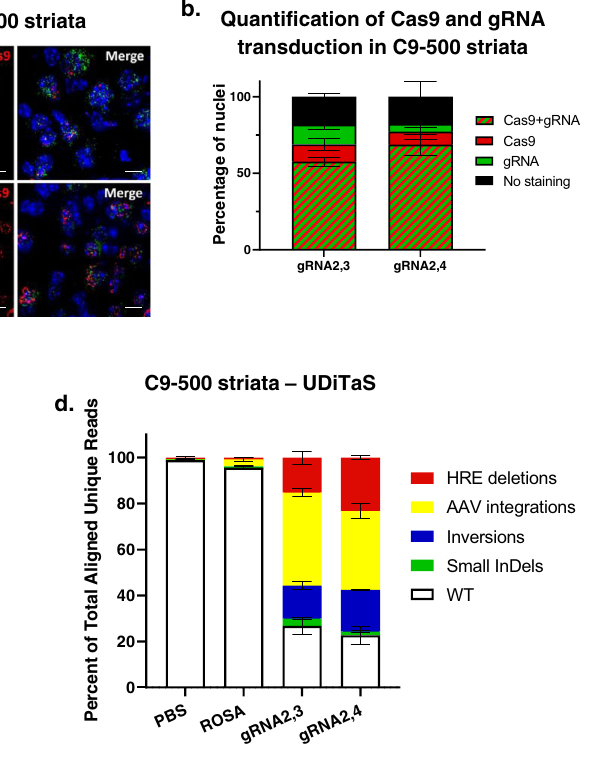
Fig. 4 | In vivo gene-editing quantity and quality in C9BAC-transgenic mouse model. a Representative ×64 images of C9-500 striata labeled with RNAscope in situ hybridization for Cas9 (red) and GFP (green) expression and nuclei (DAPI, blue) after AAV9-Cas9 and AAV9-gRNA2,3 or AAV9-gRNA2,4 treatment. The gRNA vectors expressed GFP. Scale bars represent 10 μ m. b Percentage of nuclei stained withCas9,GFP,Cas9andGFP,andnostainingofAAV9-Cas9andAAV9-gRNA2,3-or